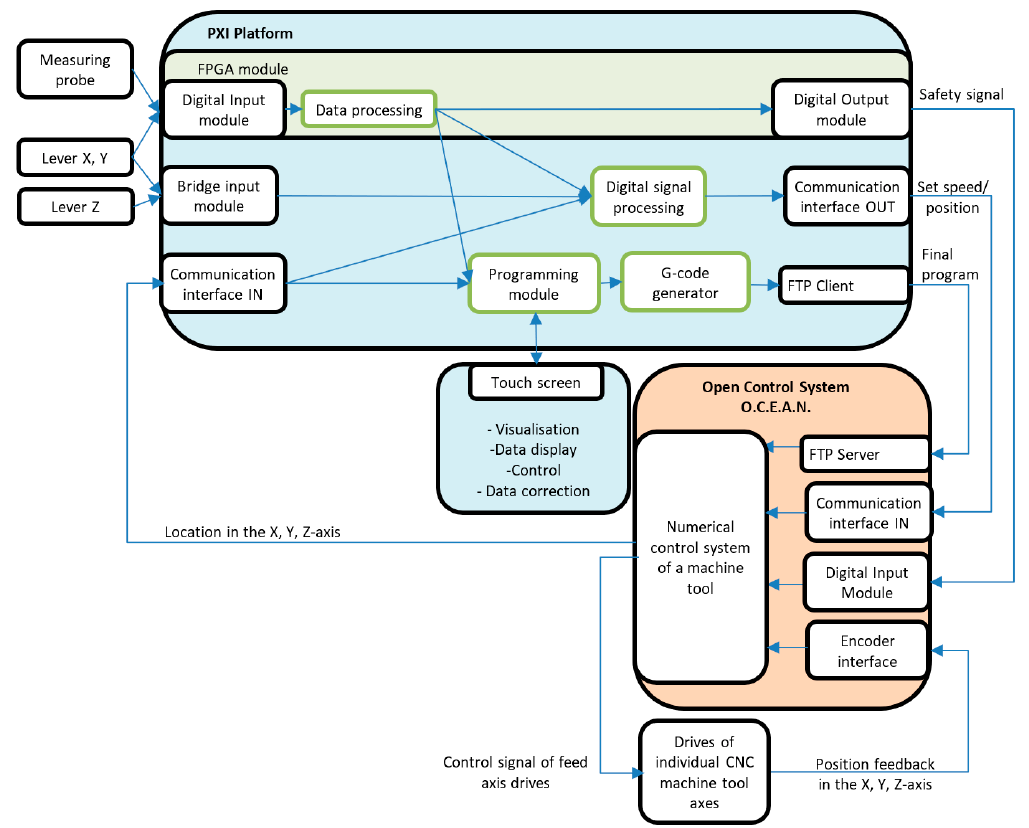
Figure 2. Block diagram of the manual guidance system for CNC machine tool.